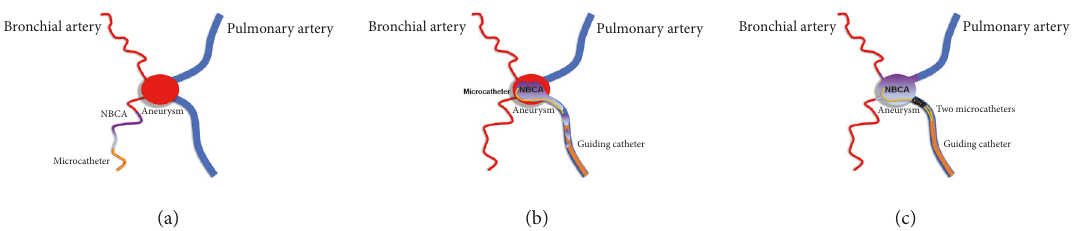
Figure 8: Schematic diagrams of the different approaches to Rasmussen’s aneurysm embolization. (a) Via the bronchial artery, only proximal embolization may be achieved because the inflow artery is small and tortuous. (b) Using the conventional approach via the pulmonary artery, selective catheterization of the aneurysm may be easy, but an unintended reflux of the NBCA cast and subsequent incomplete embolization of the aneurysm may occur with the retrograde flow. (c) Using our approach, proximal coil blocking via the pulmonary artery prevents unintended reflux of the NBCA cast and allows continuous retrograde retention of the NBCA in the aneurysm, as well as in the inflow and outflow arteries. NBCA,